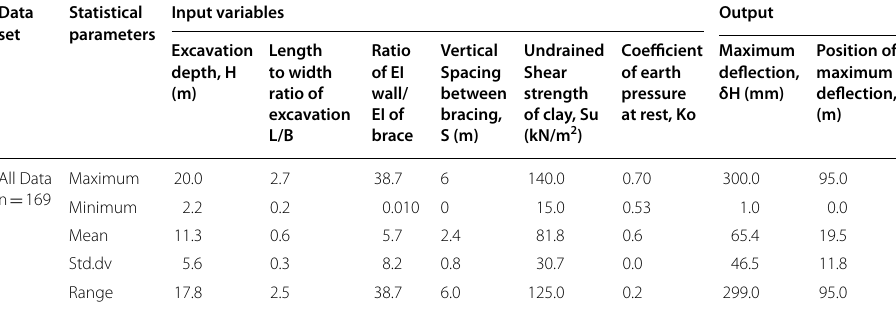
Table 2 Statistics parameters of Input and Output data used in (ANN) Data